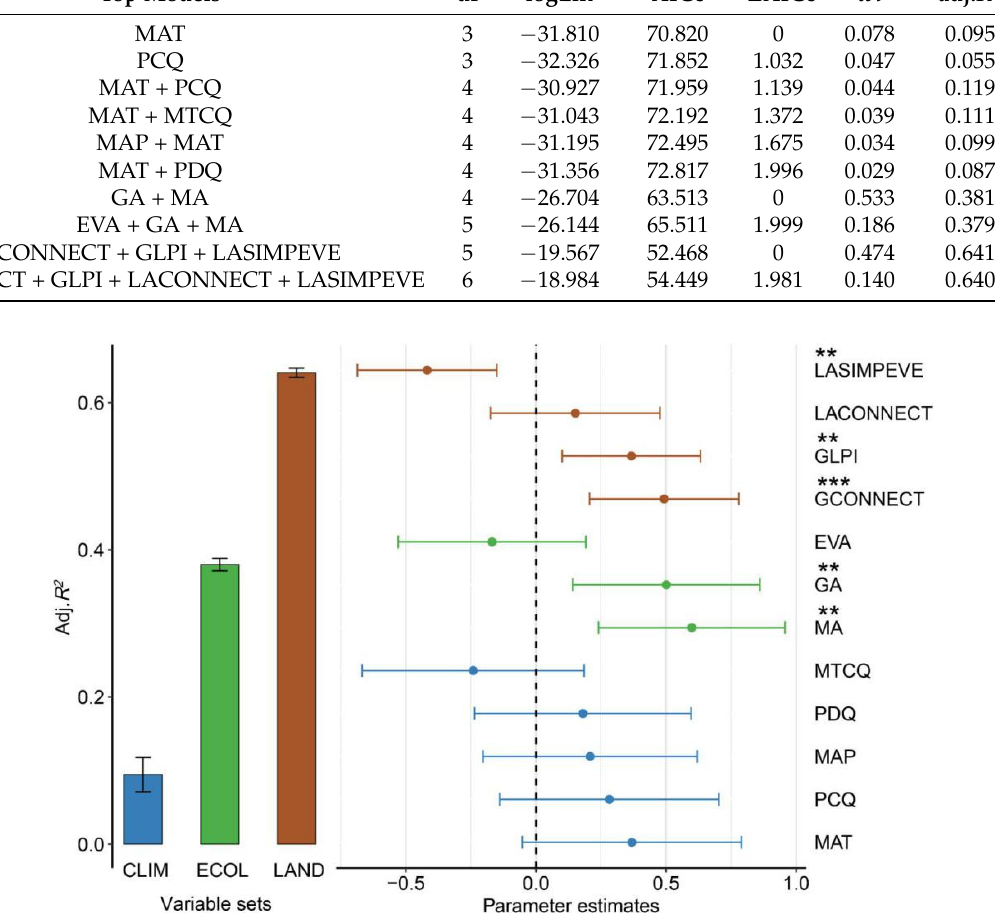
Figure 4. The overall performances of multiple regression models (histogram plot) for each variable category, explaining the population trend of the Greater White-Fronted Goose and regression coef- ficients of each variable (forest plot) featured in the best models. Adj. R 2 = adjusted R 2 . Error bars indicate 95% CI. For variables’ abbreviations, see Table 1. ** indicates p < 0.01; *** indicates p < 0.001.